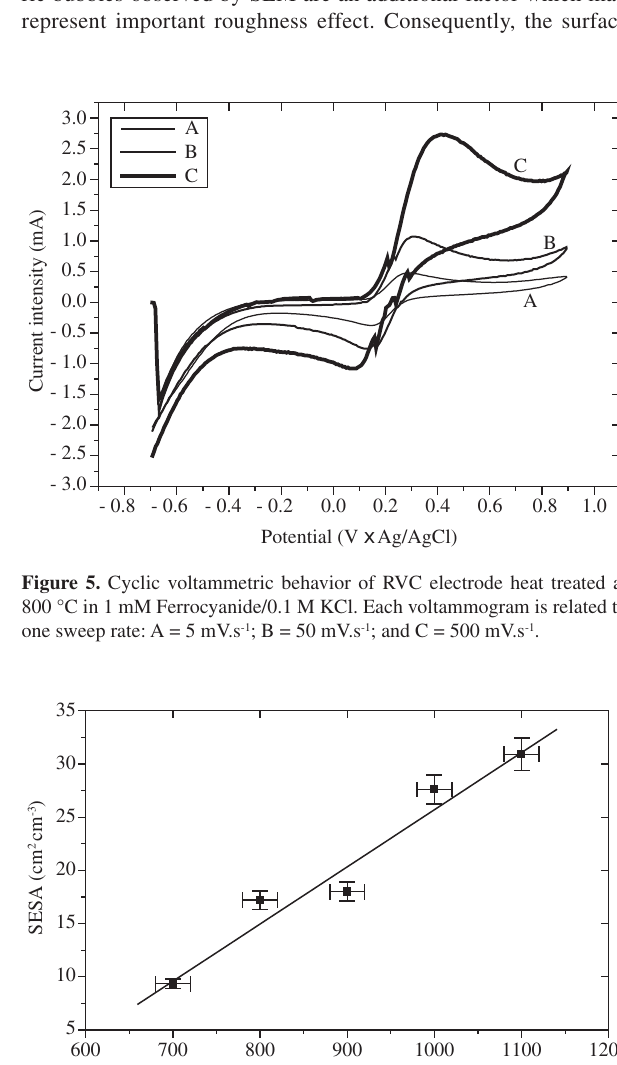
Figure 4. Lamellar planes d analysis.